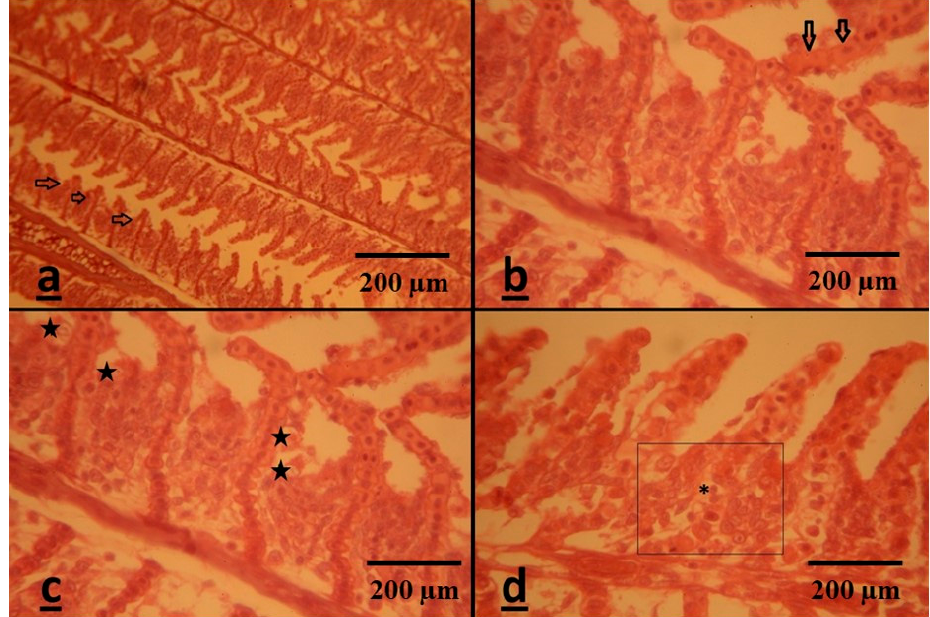
Figure 2. ( a – d ) Gill lesions of Capoeta ( Capoeta capoeta ) 96 h after exposure to different levels of Ag-NPs; ( a ) epithelial lifting of secondary lamellas (Ag-NPs were 5 mgL − 1 —magnified × 10); ( b ) epithelial hypertrophy (Ag-NPs were 5 mgL − 1 —magnified × 40); ( c ) leukocyte infiltration (Ag-NPs were 10 mgL − 1 —magnified × 40; ( d ) bottom hyperplasia (Ag-NPs were 15 mgL − 1 —magnified × 40). The regular orientation of cord-like compact hepatocytes spreading out from the cen- tral vein to the margin of the hepatic lobules was seen in a histological cross-section of C. capoeta liver tissue. Nonetheless, macrophage aggregates (MA), fatty liver (FL), sinusoid dilation (DS), and necrosis (N) were seen in Ag-NPs-treated liver cross-sections (Figure 3a–d). The liver is the primary fish organ responsible for xenobiotic metabolism, detoxifi- cation, and excretion [110]. An excess of dangerous substances impairs the body’s ability